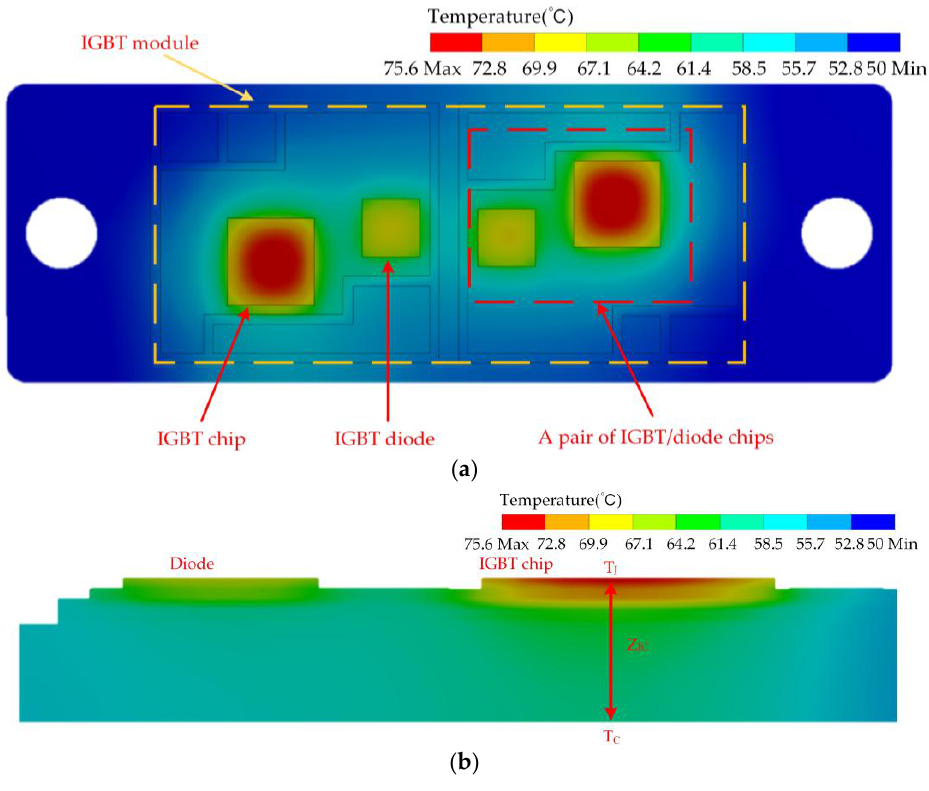
Figure 10. Temperature distribution in IGBT: ( a ) Vertical view; ( b ) Cross-sectional view.